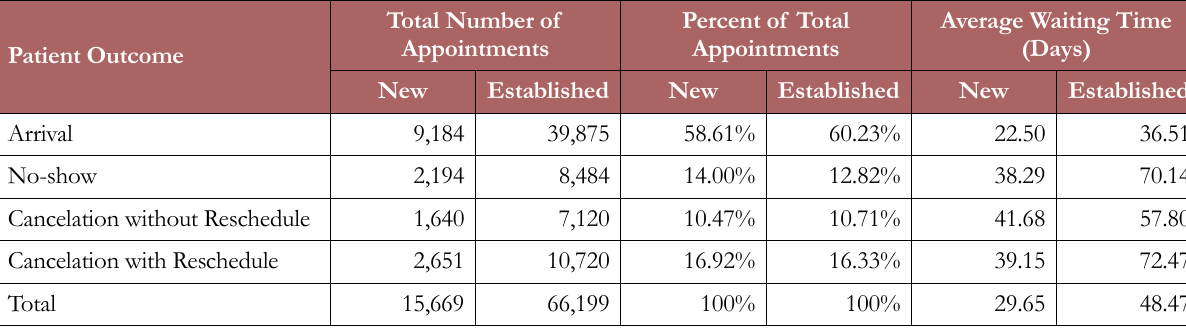
Table 1. New and established patients’ appointments by appointment-keeping